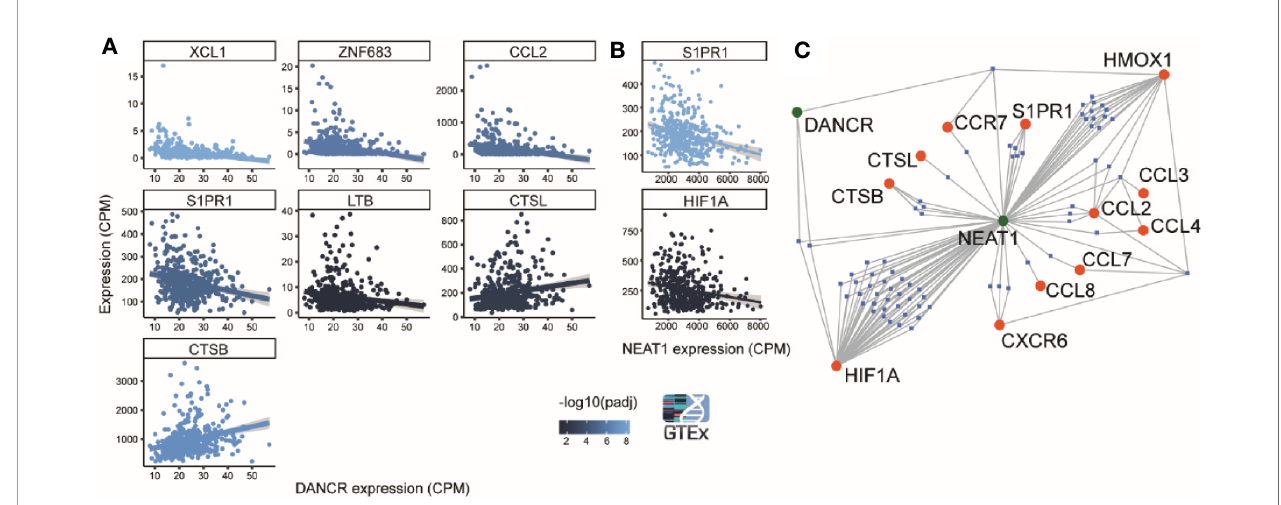
FIGURE 5 | DANCR and NEAT1 expression networks are linked to genes discriminating between mild and severe SARS-CoV-2 insults. (A) 8 out of 19 genes found by Bost et al. (2020) to change between mild and sever SARS-CoV-2 infected patients show signi fi cantly correlated changes (p<0.05) to changes of DANCR (Pearson, FDR) in lung samples of 427 post-mortem GTEx donors. Gray region around the line represents SD for the linear fi t. Line color represents signi fi cance [-log10(adjusted p value)] (86). (B) Same as A. for NEAT1. (C) A network of miRs (blue) that harbor binding sites on either DANCR or NEAT1 (green) and may target one or more of the 12 in fl ammation-related genes [(86)